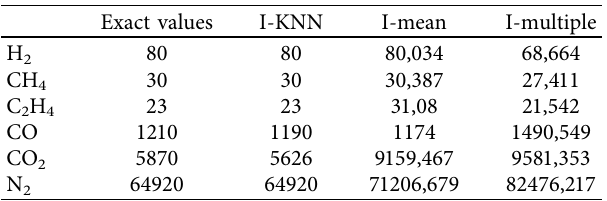
Table 5: Evolution of imputed values.